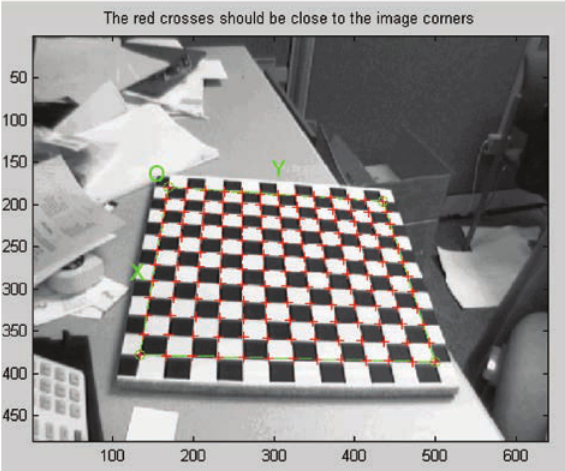
Fig. 4. The image marked with the measured plate – chess corners